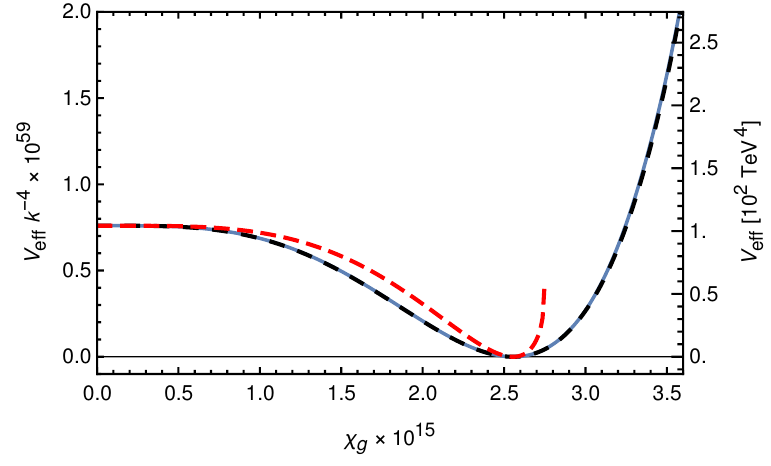
Figure 3 . E(cid:11)ective potential as a function of (cid:31) g = e A ( y 1 ) (cid:0) A ( y 2 ) . The left vertical axis is given in units of k 4 and the right one, in TeV 4 . The blue line is the e(cid:11)ective potential V e(cid:11) calculated using as interpolating radion ^ (cid:31) g . The dashed black and red lines show the e(cid:11)ective potentials V ( y ) V ( (cid:30) ) respectively. We have used the exponential potential (3.2) with (cid:20) = 0 : 5 k (cid:0) 3 = 2 , (cid:13) = 0 : 1 k (cid:0) 3 = 2 , e(cid:11) v 1 = (cid:0) 14 k 3 = 2 , v 2 = 0 : 5 k 3 = 2 , (cid:3) 2 = (cid:0) 50 k 4 , (cid:24) 1 ! 1 and (cid:24) 2 = k . Then, k = 1 : 92 (cid:2) 10 15 TeV (2.27).